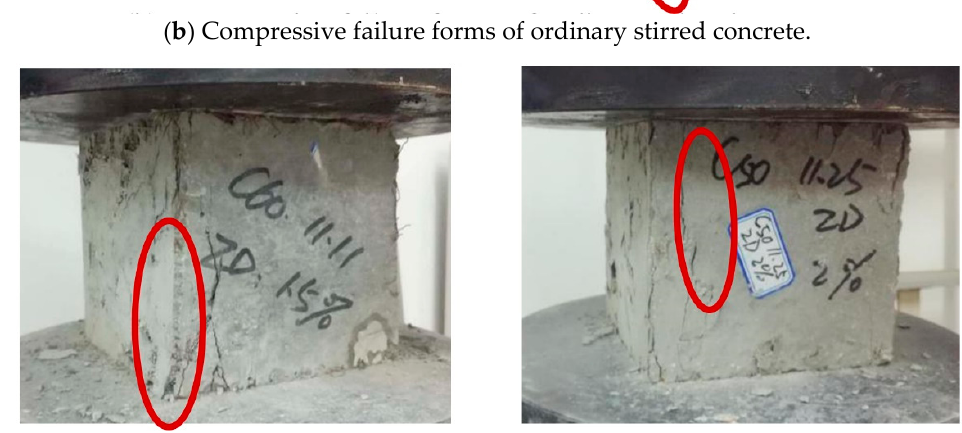
Figure 4. Concrete compressive failure forms: compressive failure forms of plan concrete ( a ), com- pressive forms of ordinary stirred concrete ( b ), and compressive failure forms of vibration-stirred concrete ( c ).